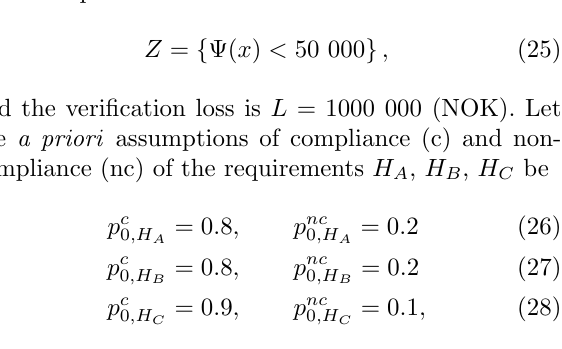
Figure 13: Reliability diagram of complex system ( A ∨ B ) ∧ C . The a priori assumptions for the compliant parts and the unexamined parts for each subsystem (or subrequirements) are indicated. The verification and examination management objective is to estimate the in- dividual x A , x B , x C examination efforts in order to fulfill the stop criterion